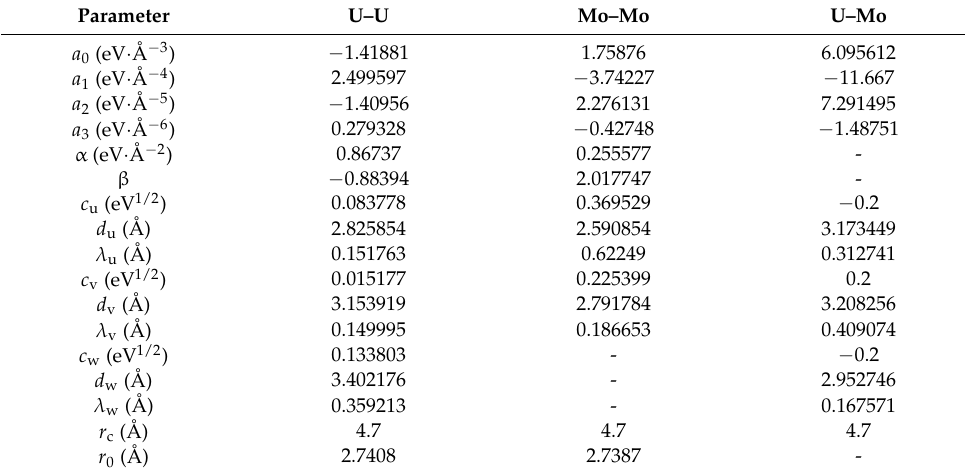
Table 1. Fitted parameters of ADP for U–Mo system.